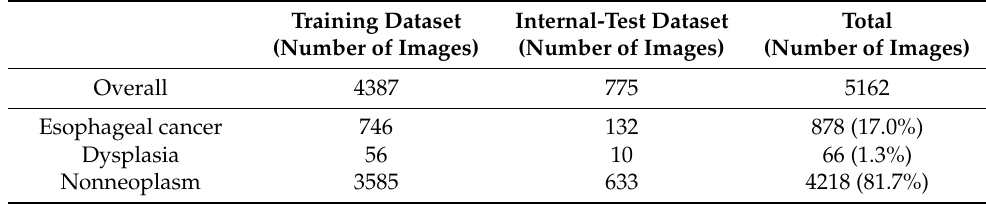
Table 1. Distribution of the collected images according to the training and internal-test datasets.